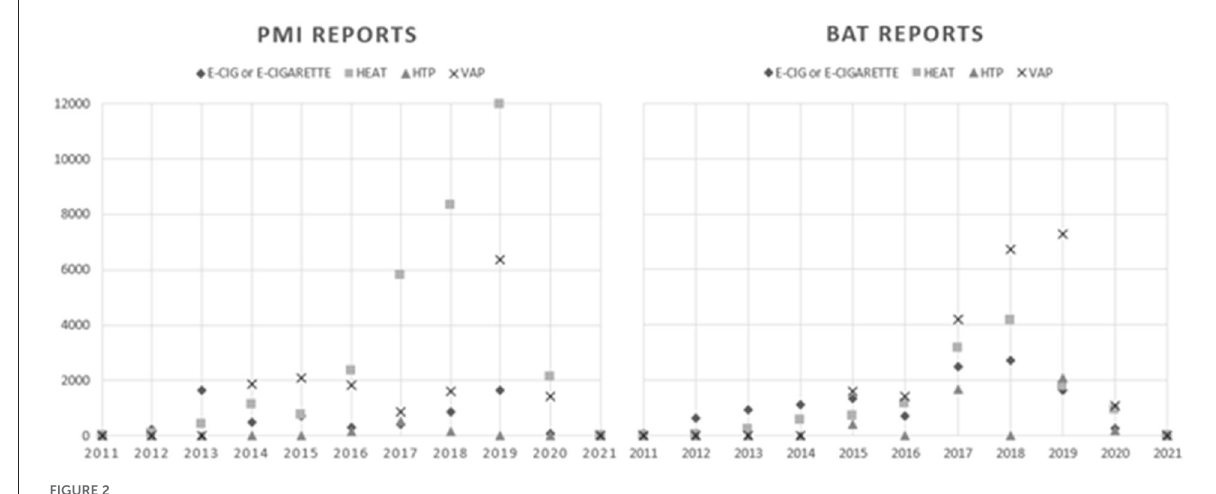
FIGURE2 Frequency of newer nicotine and tobacco product